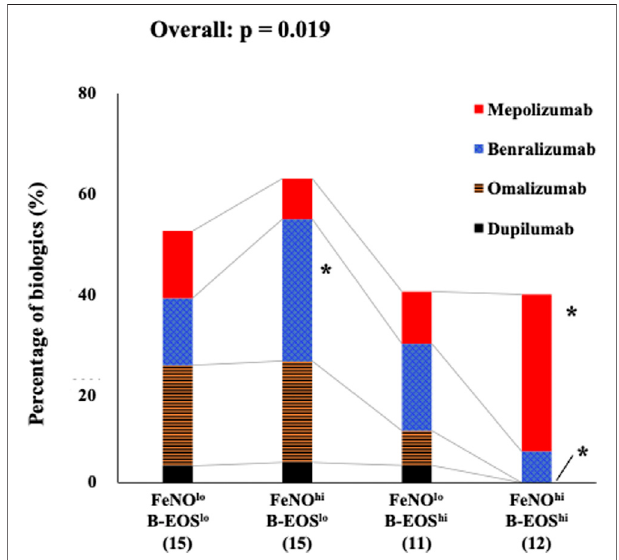
FIGURE 1 | Distribution of the prevalence of biologics use in the type 2 biomarker-classi fi ed subgroups. In the low-FeNO/low-B-EOS subgroup, omalizumab, mepolizumab, benralizumab, and dupilumab were as follows: 20.7, 13.8, 13.8, and 3.4%, respectively. In the high-FeNO/low-B-EOS subgroup: 20.8, 8.3, 29.2, and 4.2%, respectively. In the low-FeNO/high-B- EOS subgroup: 7.1, 10.7, 17.9, and 3.6%, respectively. In the high-FeNO/ high-B-EOS subgroup: 0.0, 32.3, 6.5, and 0.0%, respectively. Values were analyzed using Fisher ’ s exact test. * , signi fi cantly high or low, compared with the other FeNO/B-EOS subgroups.